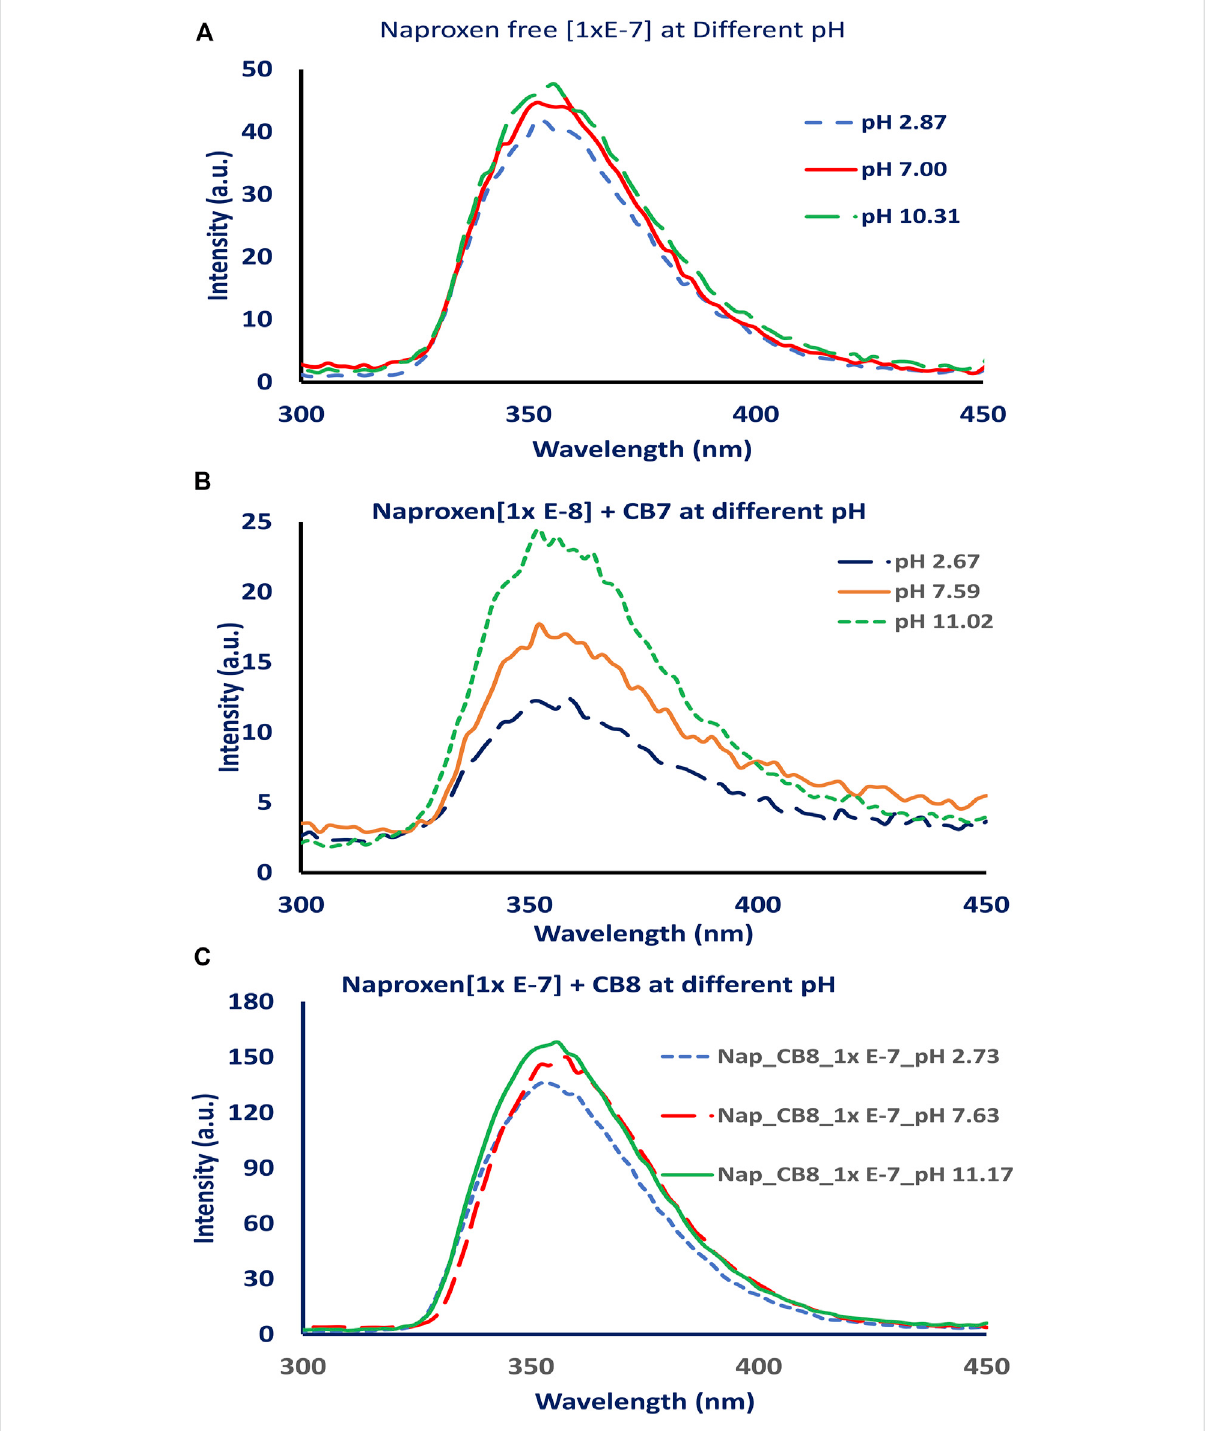
FIGURE 2 Fluorescencespectra ofnaproxen atdifferent pHvalues(pH2, 7 and11), (A) without adding CBs, (B) after adding CB7, and (C) after adding CB8.